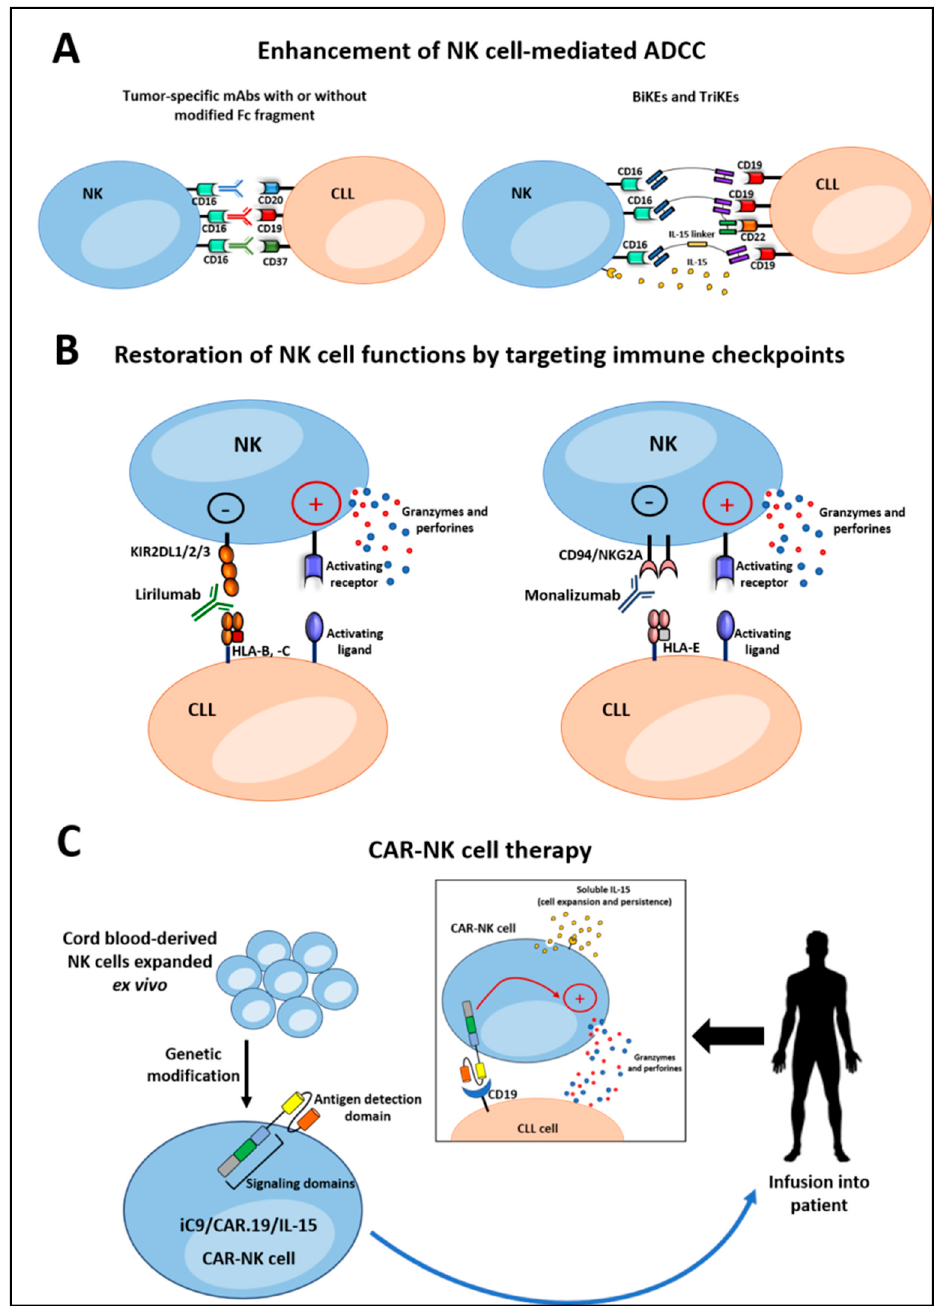
Figure 3. Natural killer ( NK) cells in chronic lymphocytic leukemia (CLL) immunotherapy. Different strategies have been developed to harness NK cell activity against CLL cells: ( A ) Enhancement of NK cell-mediated antibody-dependent cellular cytotoxicity (ADCC) using tumor-specific monoclonal antibodies (mAbs) (left) or bispecific and trispecific killer cell engagers (BiKE and TriKE) (right). ( B ) Restoration of NK cell functions using mAbs targeting immune checkpoints. ( C ) Chimeric antigen receptor (CAR)-NK cell therapy.